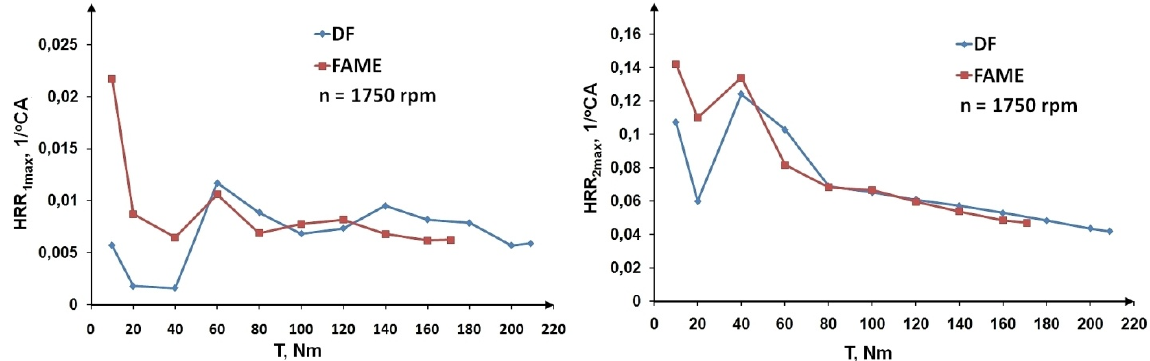
Figure 8: The maximum values of the first and second maximum of the relative heat release rate HRR 1max , HRR 2max during the combustion process in the cylinder of the Fiat 1.3 MultiJet engine, working according to the load characteristics for n = 1750 rpm, supplied with the